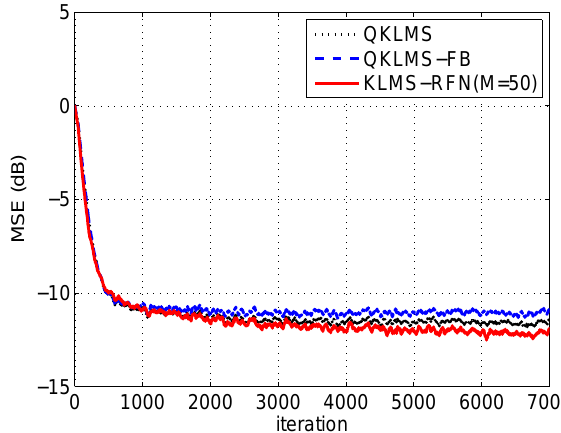
Figure 9. The learning curves of the QKLMS, QKLMS-FB, and KLMS-RFN algorithms in time-varying channel equalization.